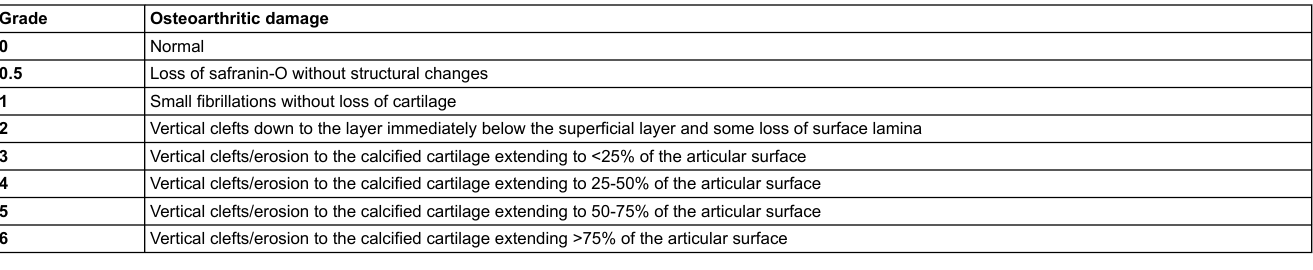
Table S1: OARSI scoring system.